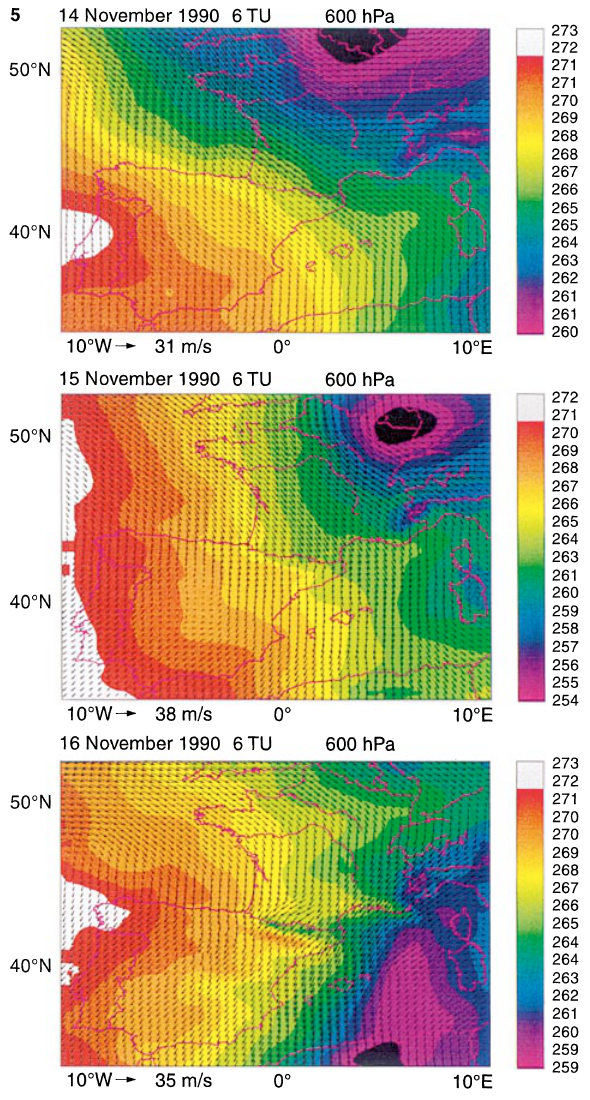
Fig. 5. Same as Fig. 4 but for 14, 15 and 16 November 1990 at